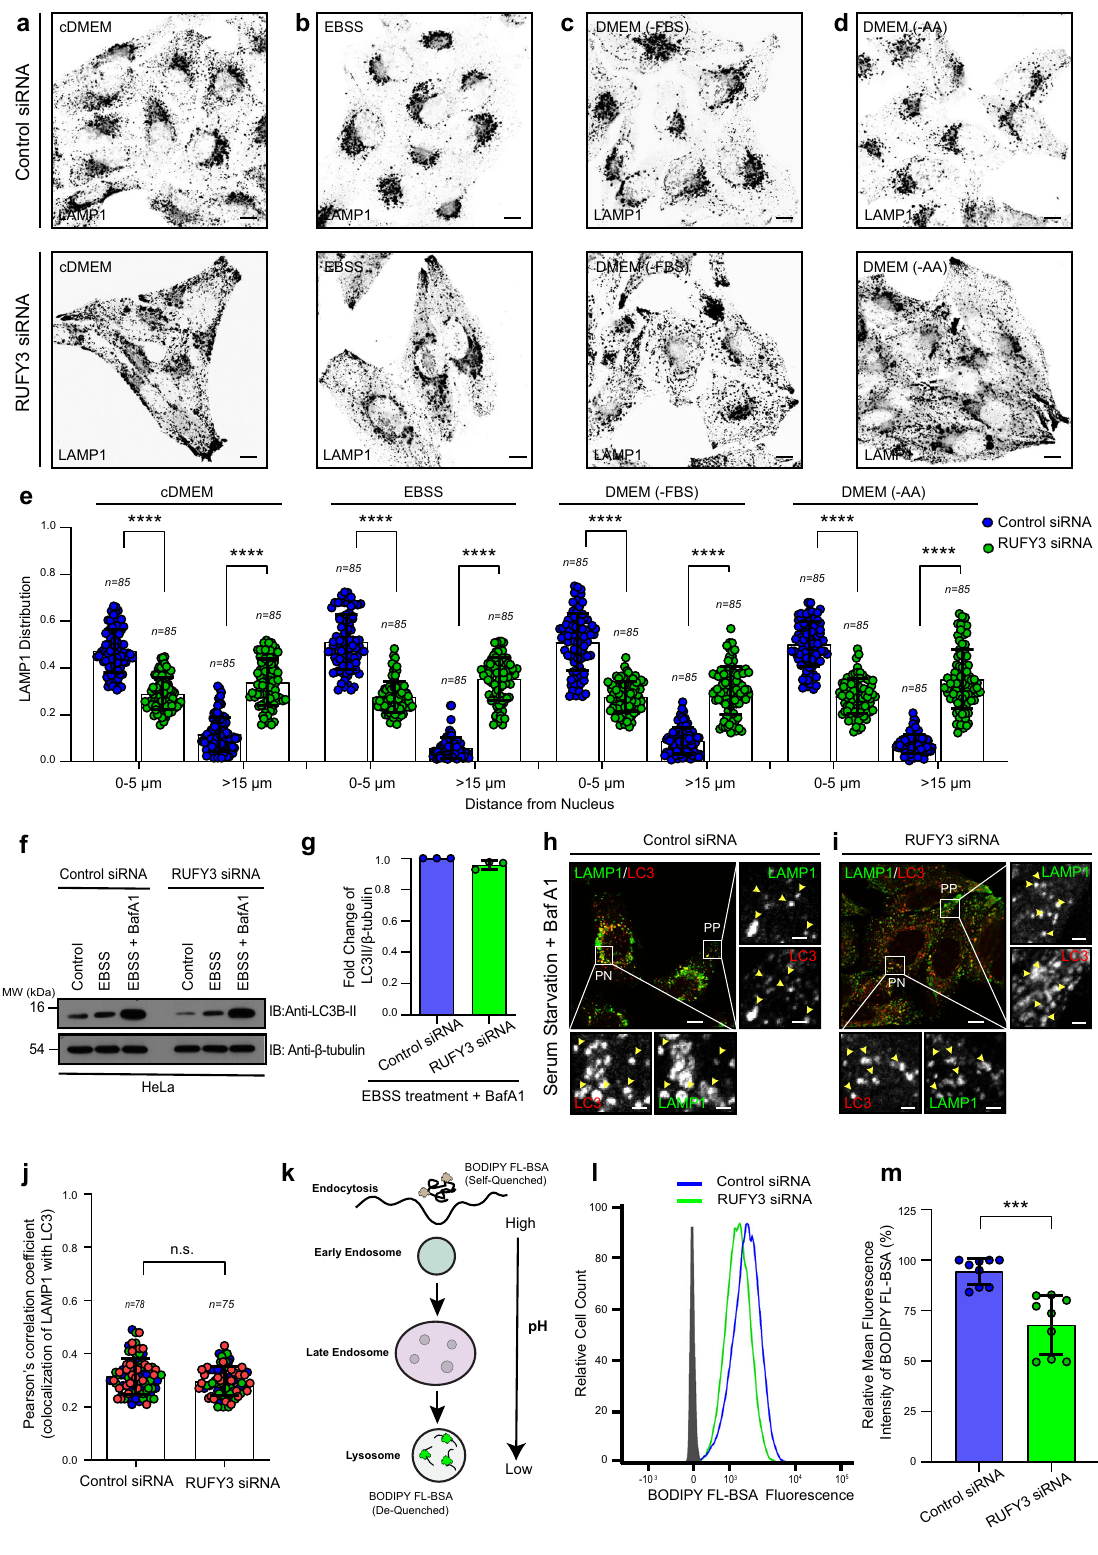
concentration of 340 µM in lysis